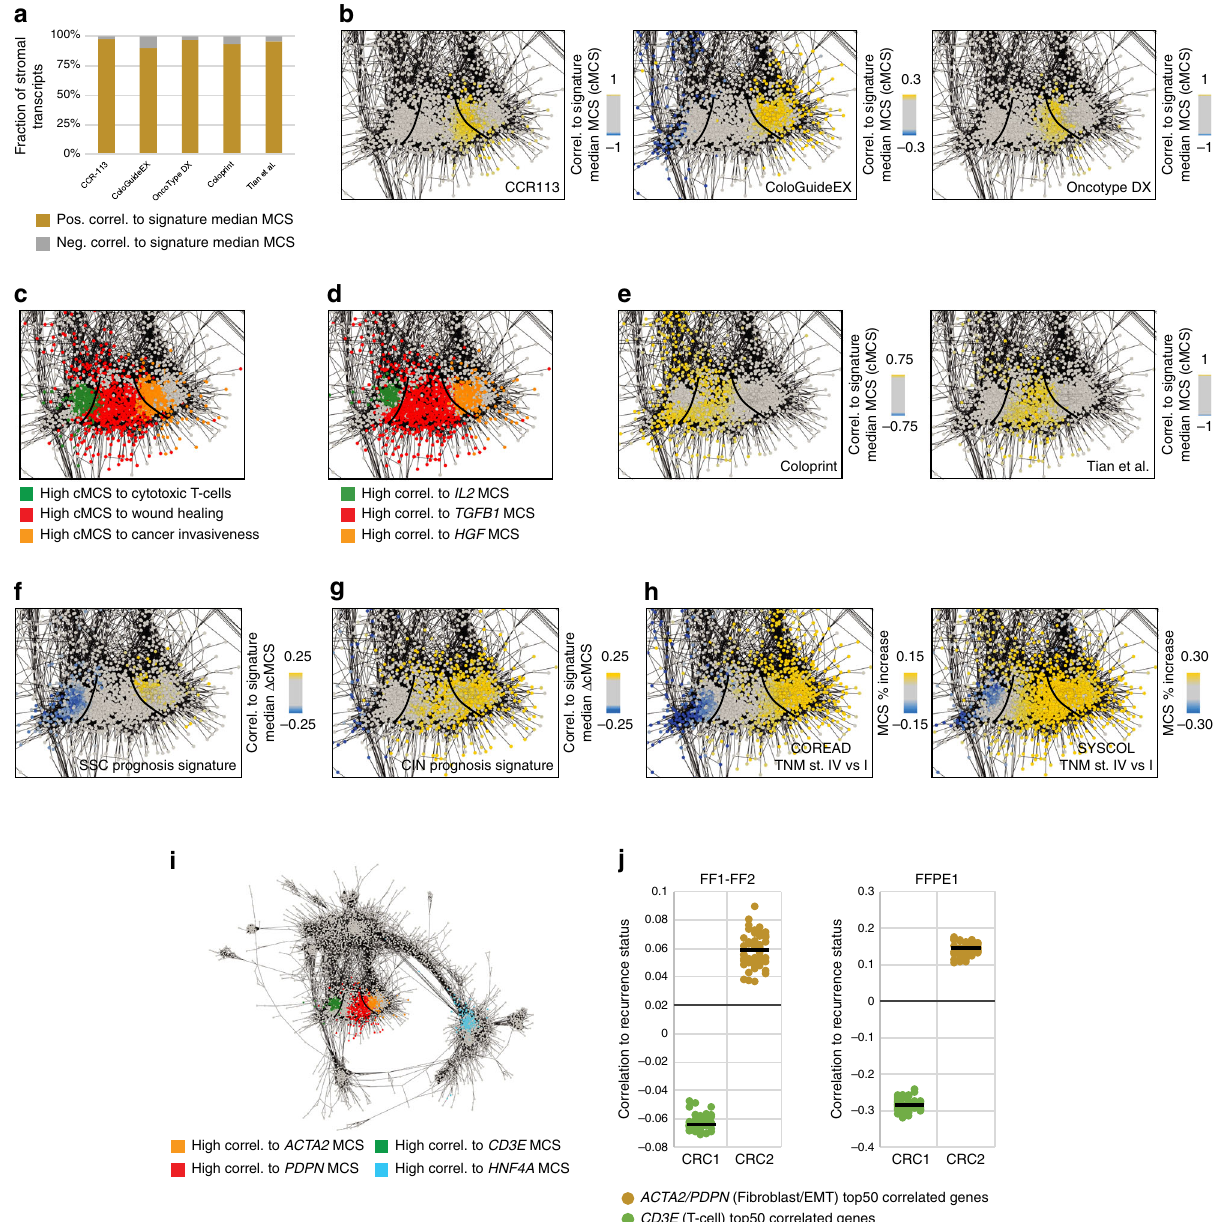
Fig. 4 The MethCORR map suggests cell types associated with prognostic RNA signatures. a Bar plot showing the fraction of stromal genes (stroma score > 0.5) that have positive or negative cMCSs (correlation to the median MCS) calculated for fi ve prognostic RNA signatures CRC-113 36 , CologuideEx 37 , Oncotype DX 38 , Coloprint 39 , and Tian et al. 40 (see “ Methods ” for calculation of cMCSs). Stromal transcripts were signi fi cantly enriched among positively vs. negatively correlated transcripts for all fi ve signatures ( P value < 10 − 100 , Wilcoxon rank sum test). b Magni fi cation of the TME cluster, where genes with the highest cMCSs for the prognostic CRC-113 36 (left), CologuideEx 37 (middle), and Oncotype DX 38 (right) signatures are highlighted. c Magni fi cation of the TME cluster, where genes with the highest cMCSs for published gene sets de fi ning cytotoxic T-cells (MSigDB M13247 29 (BioCarta); green), wound healing (MSigDB M11957 29,73 ; red), or cancer invasiveness (MSigDB M2572 29,74 ; orange) are highlighted. d Magni fi cation of the TME cluster, where genes with the highest correlation to the MCS of the IL2 (green), TGFB1 (red), and HGF (orange) genes are highlighted. e Magni fi cation of the TME cluster, where genes with the highest cMCSs for the prognostic Coloprint 39 (right) and Tian et al. 40 (left) signatures are highlighted. f Magni fi cation of the TME cluster, where genes with the highest Δ cMCSs for the prognostic SSC prognosis signature 3 and g the CIN prognosis signatures 3 are highlighted. h Magni fi cation of the TME cluster colored according to the gene-speci fi c percentage change in median MCSs between TNM stage I and IV CRCs of the COREAD cohort (left) and SYSCOL cohort (right). i Magni fi cation of the TME cluster, where genes with the highest correlation to the MCS of CD3E (green), PDPN (red), ACTA2 (orange), and HNF4A (blue) are highlighted. j Scatterplot showing the Spearman rho for top CD3E or ACTA2 / PDPN - correlated genes to positive relapse recurrence status in the CRC1 and CRC2 subtypes, respectively, in the fresh-frozen FF1 – FF2 cohort (left) and FFPE1 (right) cohort. Median correlation is indicated by a black